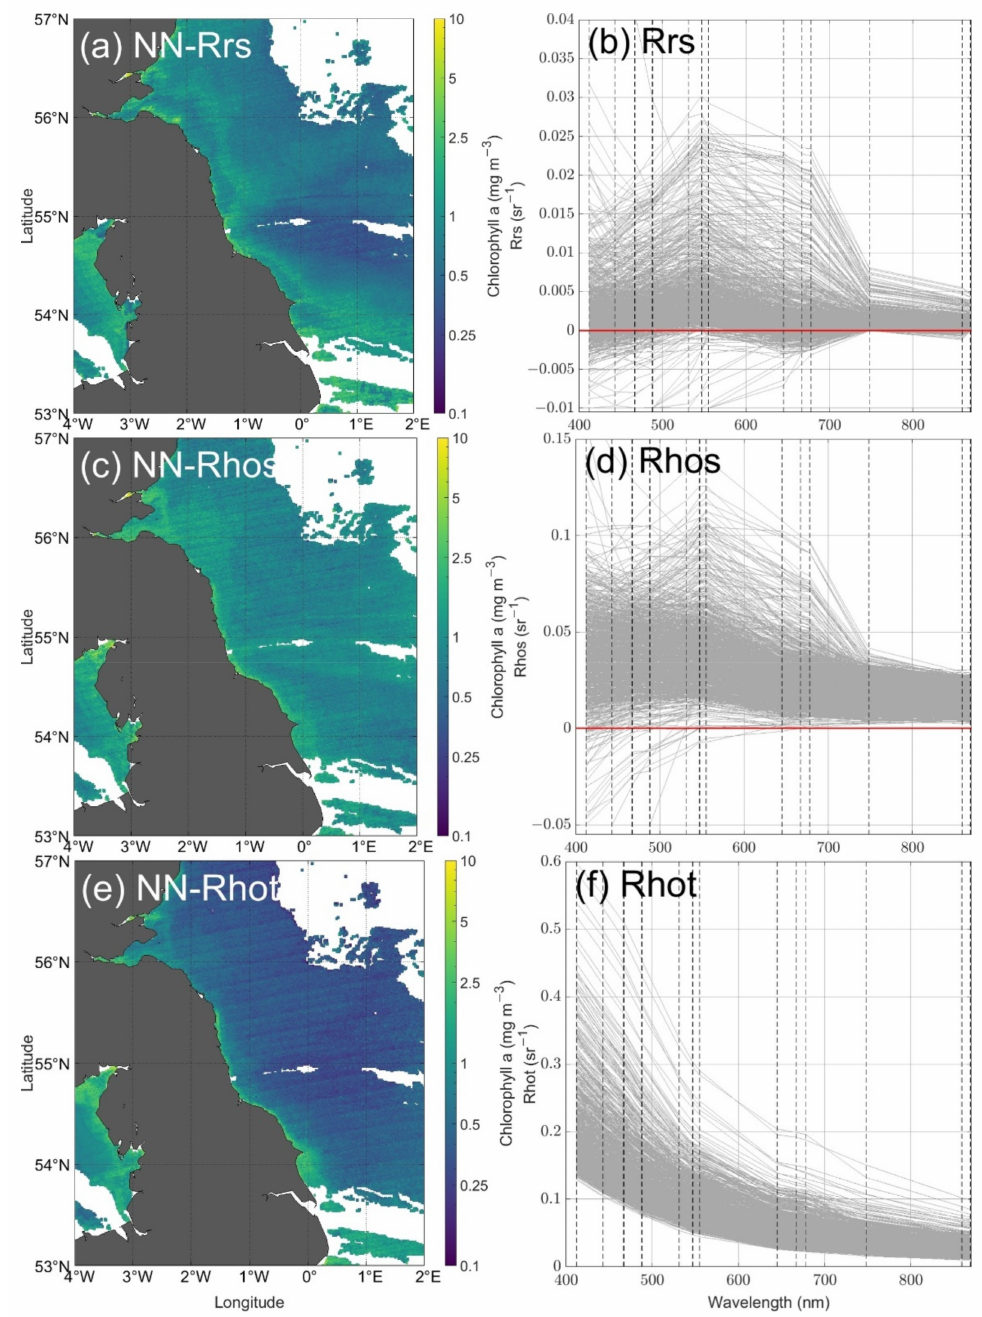
Figure 5. Winter image of the 31 December 2019, 13:05 from MODIS-Aqua, highlighting the atmo- spheric correction noise present near the Firth of Forth, western North Sea for the Rrs ( a ) and Rhos ( c ). Absent from the Rhot product ( e ) and 1000 spectra examples from the matchup data set, for Rrs ( b ), Rhos ( d ) and Rhot ( f ). Only the first 13 of the 15 bands of MODIS Aqua available for this study are displayed with dashed